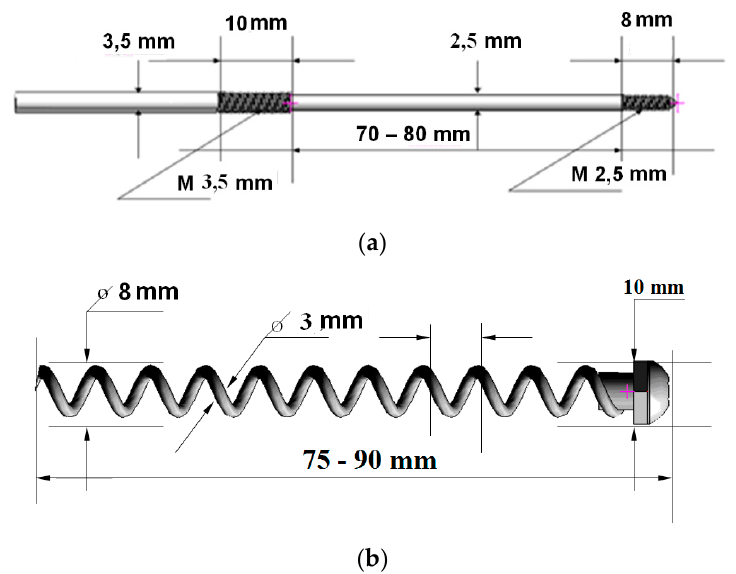
Figure 10. Two types of the implant systems used: (( a ) a pin; ( b ) a spiral) and their application using the INSTRON 5982 dynamometer.